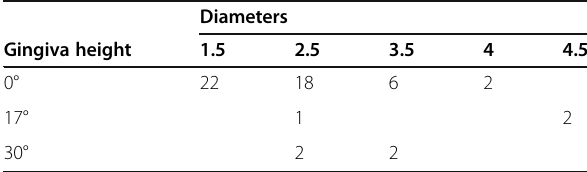
Table 2 Distribution of screw-retained abutments according to gingiva height and